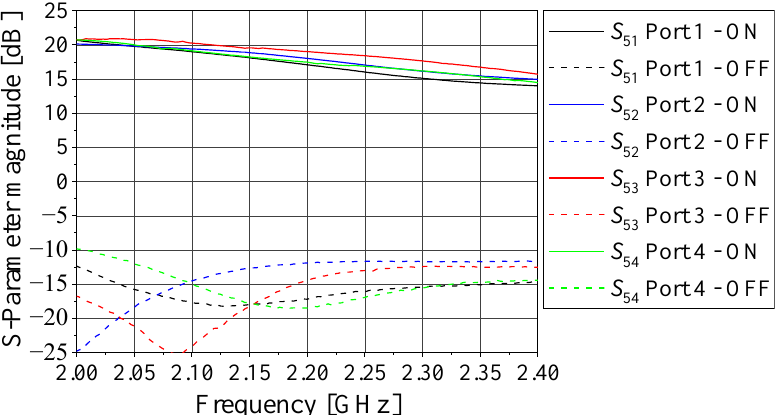
Figure 9. Magnitude of the transmission coefficients 𝑆 5𝑛 .